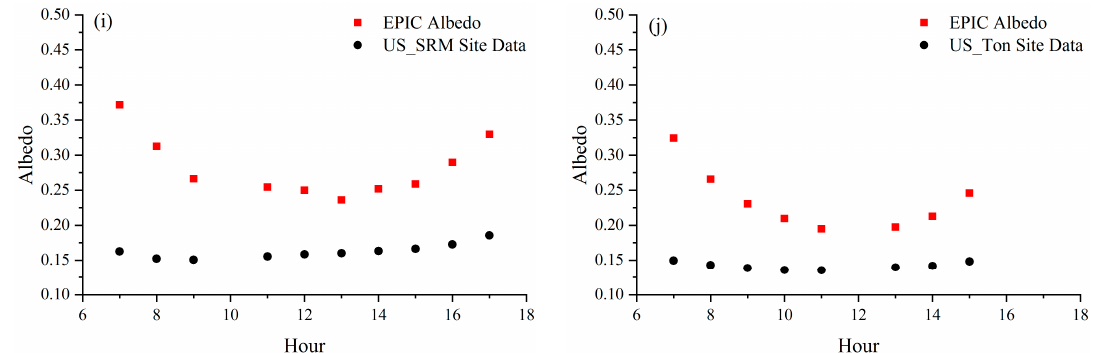
Figure 6. Analysis of the diurnal variation of EPIC albedo over different land cover types. The land cover type of ( a )-( b ) is croplands, ( c )-( d ) is evergreen needleleaf forests, ( e )-( f ) is grasslands, ( g )-( h ) is permanent wetlands, and ( i )-( j ) is woody savannas. The date of ( a ), ( e ) is 16th June 2016; ( b ), ( g ), ( h ) is 12th June 2016; ( c ) is 15th July 2016; ( d ) is 8th June 2016; ( f ) is 18th June 2016; ( i ) is 19th June 2016; and ( j ) is 20th June 2016.